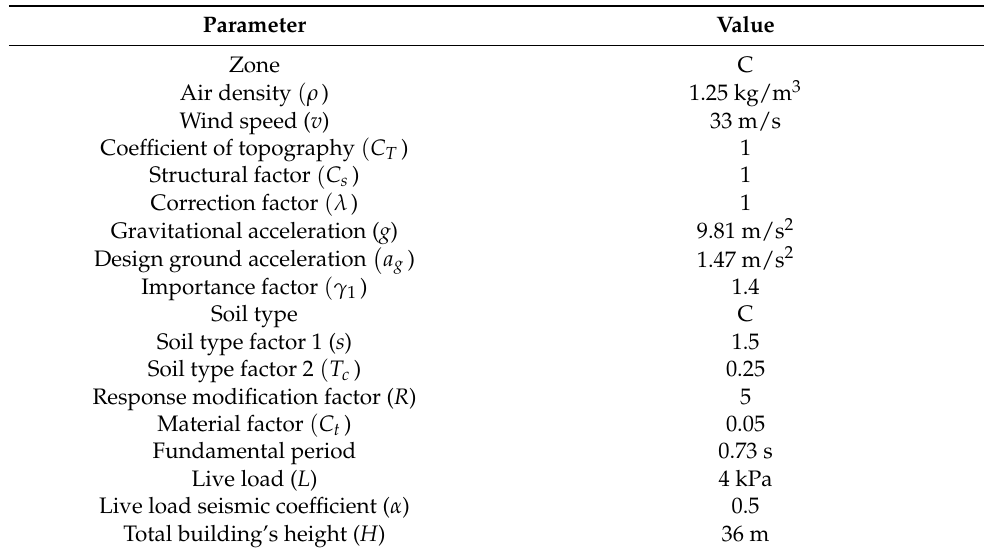
Figure 6. Lateral earthquake load distribution. Table 3. Lateral design